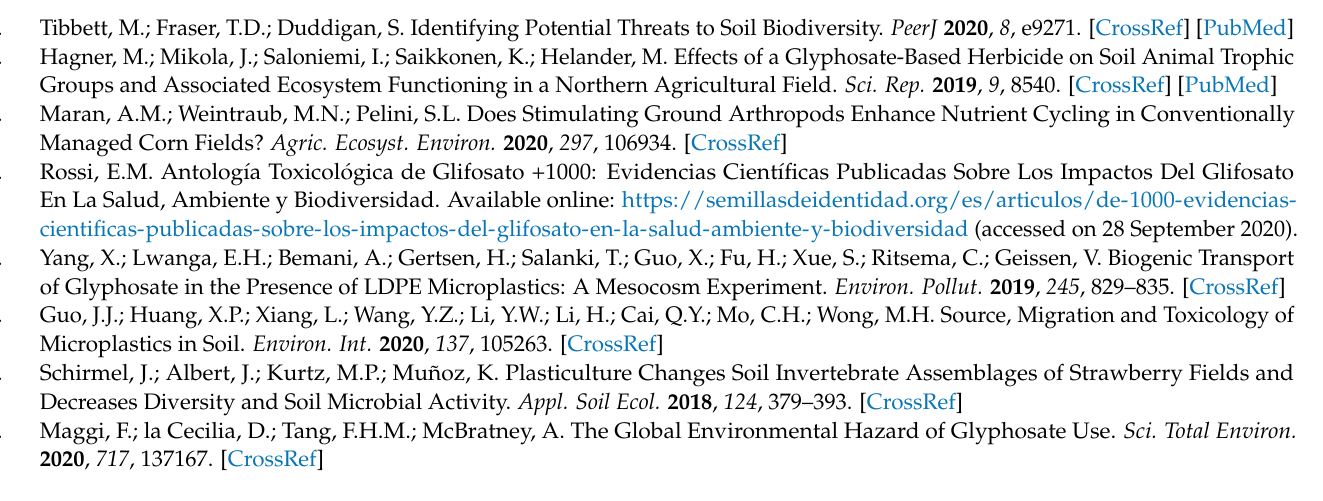
ber of individuals per sampling point per order. n = number of sampling points for statistical analysis, Table S4: Correlations between soil microplastics count (MPs, n = 66), soil glyphosate concentration (GLYsoil, n = 24), soil AMPA concentration (AMPAsoil, n = 24) and glyphosate in invertebrate tissue (GLYinv, n = 72) with the number of morphospecies per sampling point per order. n = number of sampling points for statistical analysis, Table S5: Correlations between global abundance and global diversity with relative abundance by order of above-ground invertebrates ( n = 72). n = number of sampling points for statistical analysis, Table S6: Correlations between global richness and global diversity with relative richness by order of above-ground invertebrates ( n = 72), Table S7: Correlation between the number of individuals per sampling point (#ind SP − 1 ) per orders of soil invertebrates ( n = 72). n = number of sampling points for statistical analysis., Table S8: Correlation between num- ber of morphospecies per sampling point (#mphs SP − 1 ) per orders of above-ground invertebrates ( n = 72). n = number of sampling points for statistical